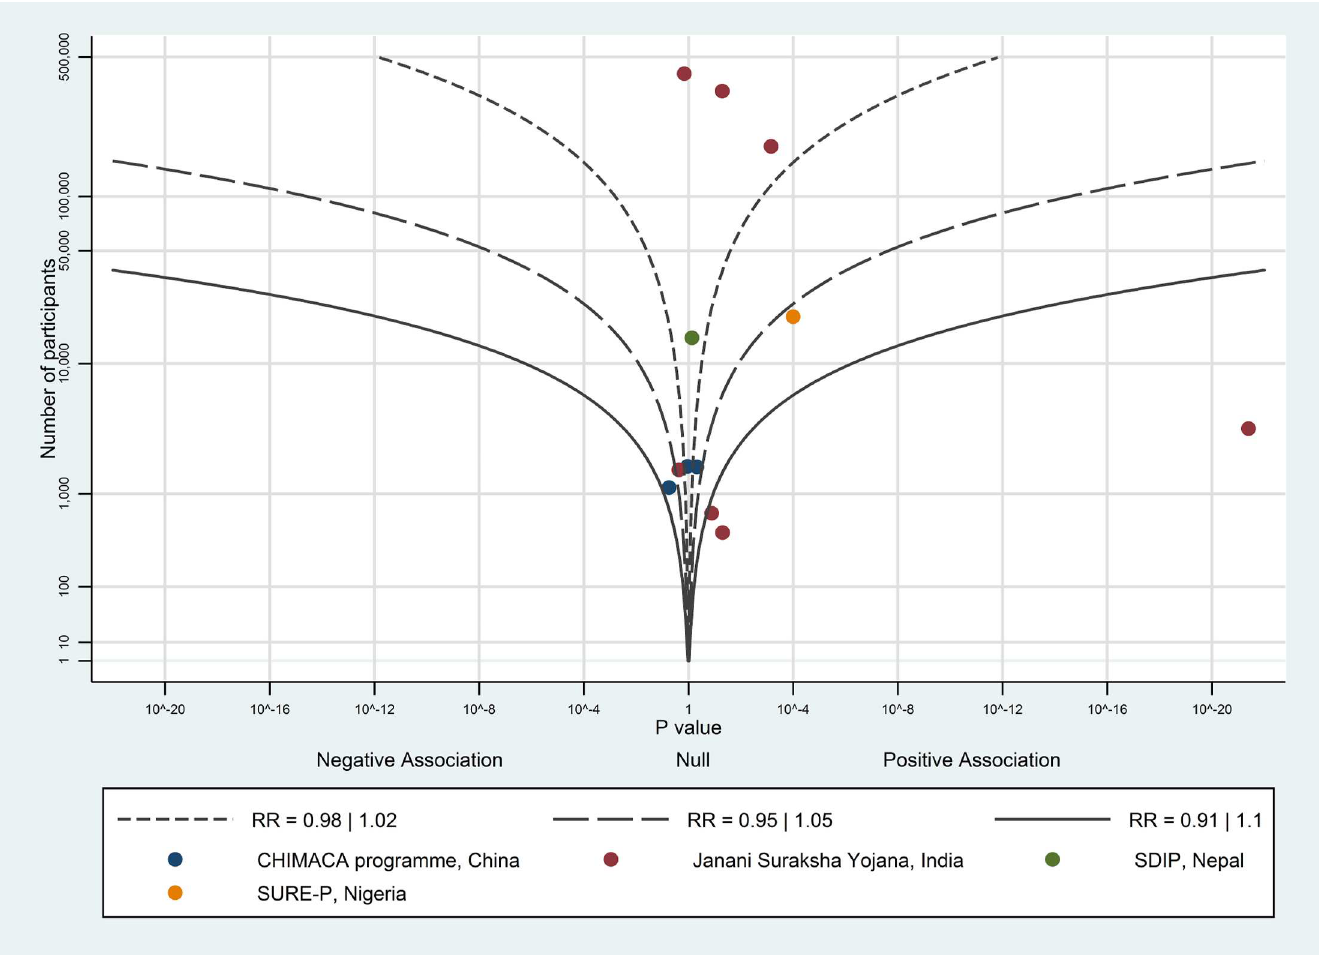
Fig 4. Albatross plot for effect of short-term cash payments on uptake of antenatal care. SDIP—Safe DeliveryIncentive